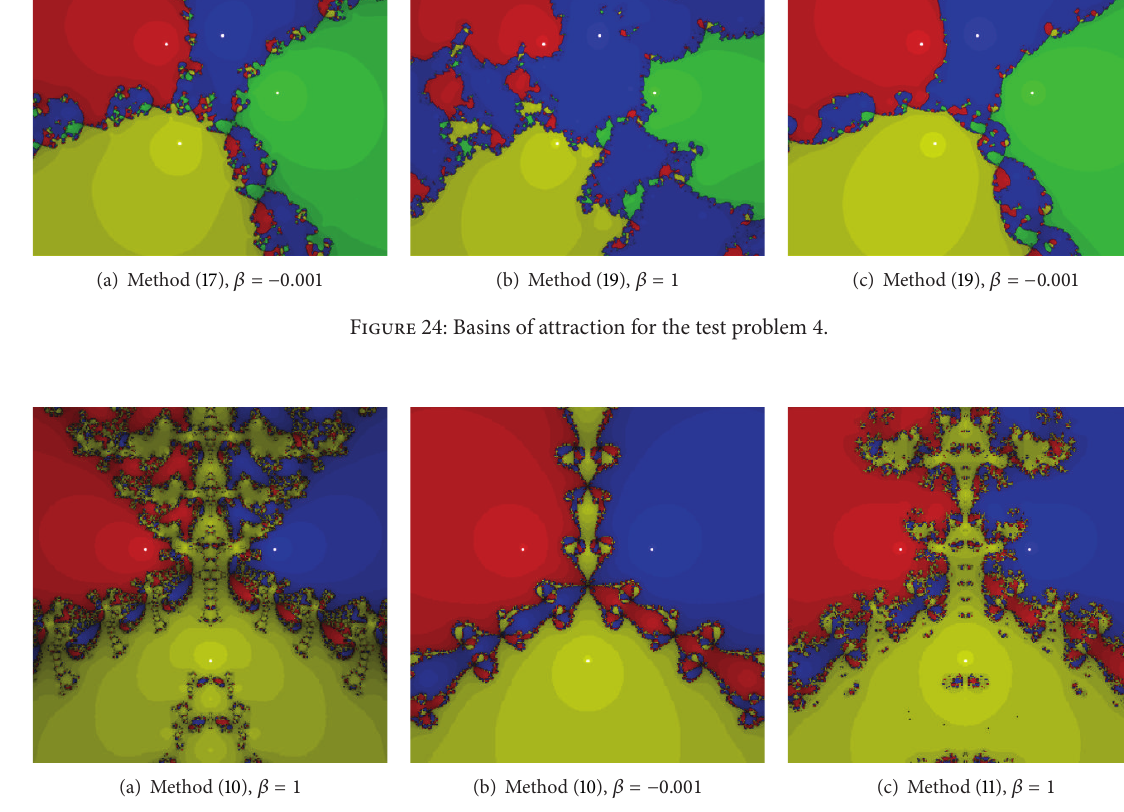
Figure 25: Basins of attraction for the test problem